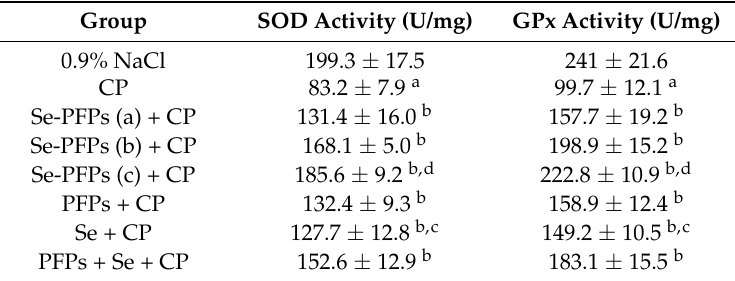
Table 4. Superoxide dismutase (SOD) and glutathione peroxidase (GPx) activities in the liver of mice after various treatments ( n =